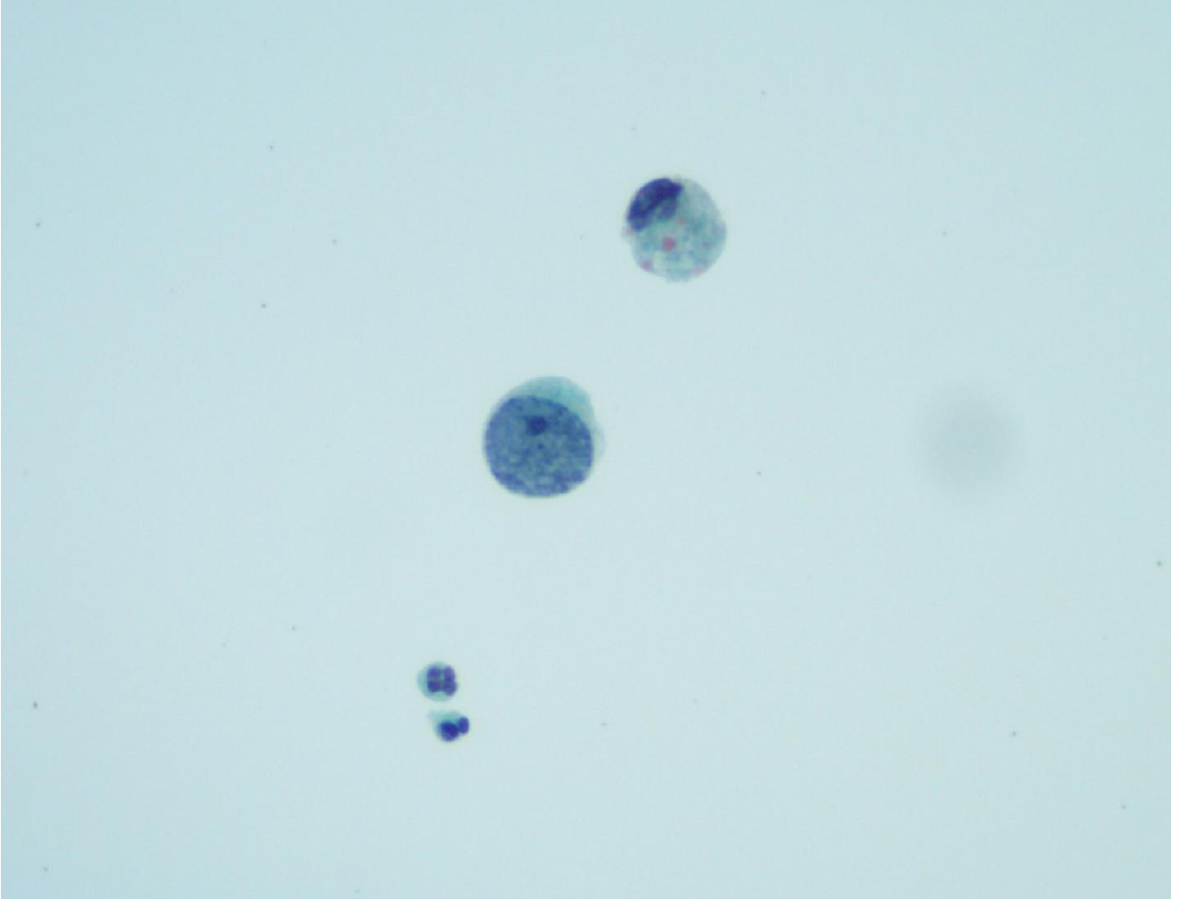
Figure 1. A “decoy cell” with an enlarged nucleus and clumped chromatin, mimicking high-grade urothelial atypia. PAP smear 600×. Courtesy of Zareema Mangaru, DO.